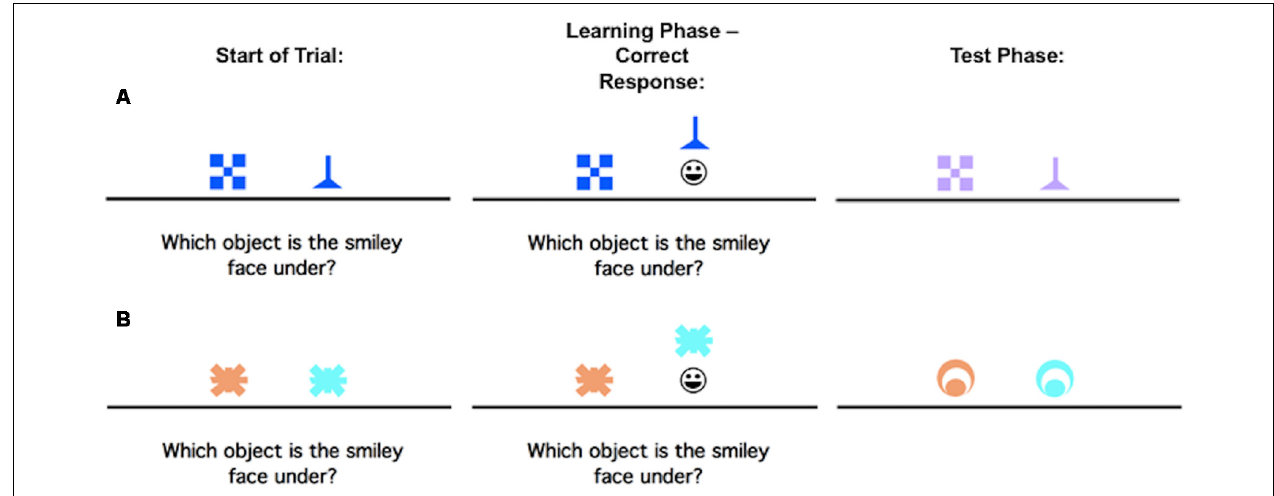
FIGURE 1 | An example of the concurrent discrimination and generalization task. On each trial of Phase 1 (acquisition/learning), the discrimination pair is presented and if the participant responds correctly, the chosen object is raised to reveal a smiley face icon underneath. During Phase 2 (generalization/test), events are similar to Phase 1, but the objects are changed so that the relevant feature remains the same, but the irrelevant feature is novel. (A) is an example of a trial where the relevant feature is shape, but not color, while (B) is an example of a trial where the relevant feature is color, but not